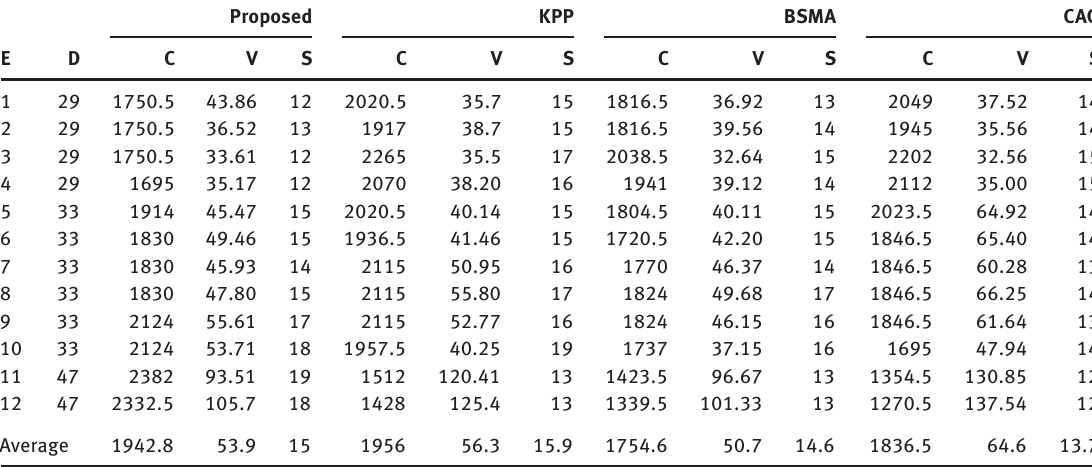
Table 3. Comparison of Dynamic Greedy Algorithm, BSMA, KPP, and CAO.